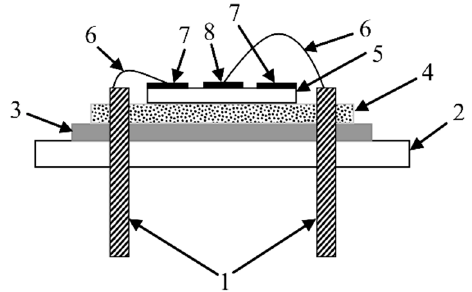
Figure 2. Holder for the resonator (side view): 1—copper contacts for connection to the measuring device (material; copper plate 1.2 mm); 2—plastic plate 3 mm thick; 3—cardboard 1 mm thick; 4—foam rubber 6 mm thick; 5—piezoceramic plate; 6—gold wire; 7—outer ring electrode of the resonator; and 8—inner round electrode of the resonator.